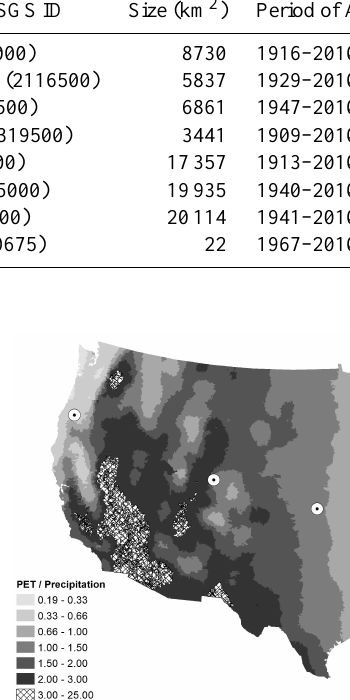
Table 1. Summary information of watersheds used in comparative analysis. Figure River Gage Location & USGS ID Size (km 2 ) Period of Analysis